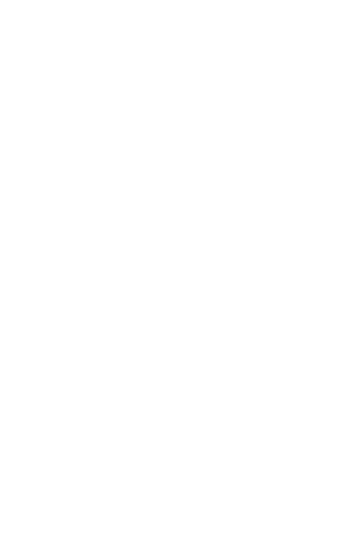
The majority of the patients included in the study, 1,437 (81.4%), were prescribed some type of psychiatric co-medication. The most prevalent concomitant medications were anxiolytics in